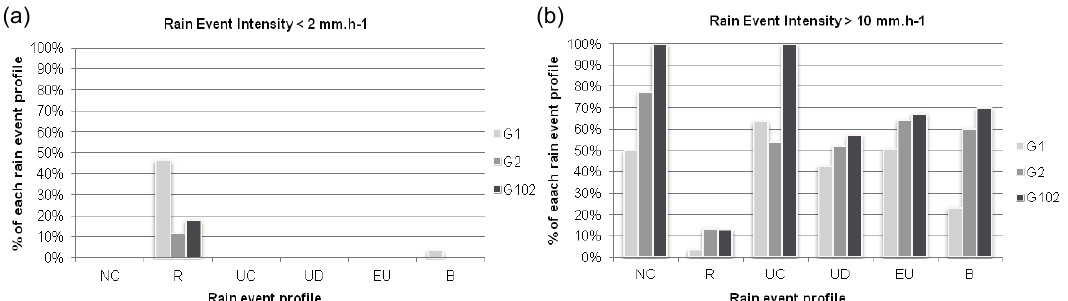
Fig. 5 Rainfall event intensity classification distributed to two